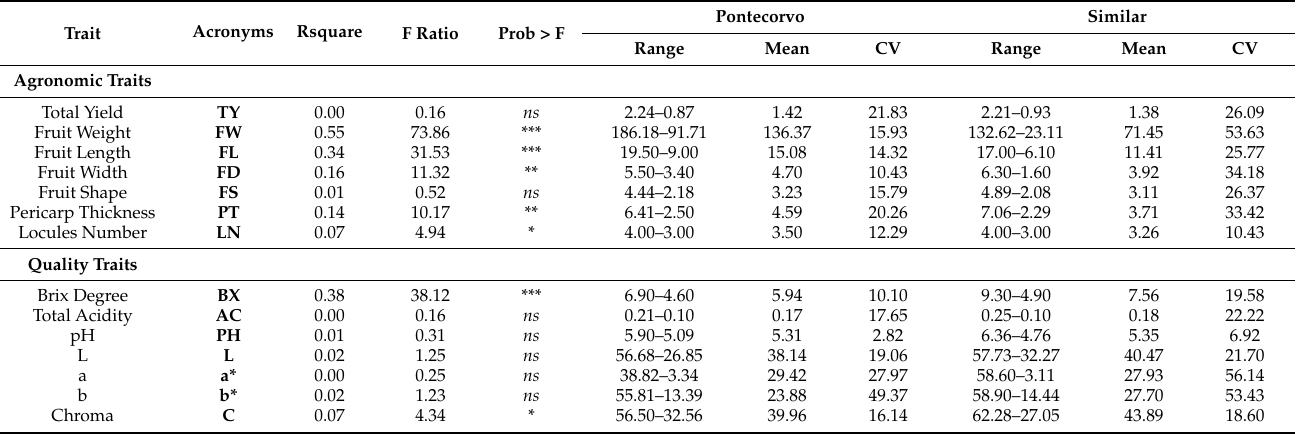
Table 3. MANOVA descriptive statistics, range, mean, and coefficient of variation (CV) for agronomic and qualitative traits analysed in the CP accessions and similar